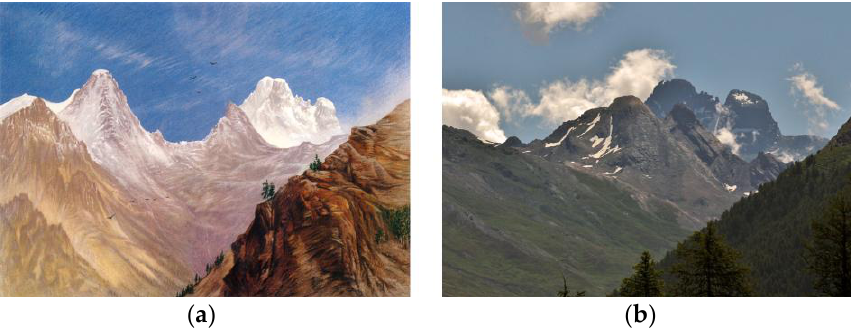
Figure 3. Example of pictorial distortion of orography and pictorial artefacts to produce a sublime image, evident in this comparison of a painting and a photograph of Monte Viso in the Cotian Alps. ( a ) Painting of the second half of 19th century by Elijah Walton (1832–1880) [29] (p. 130); ( b ) Photograph of Monte Viso from approximately the same point of view as the painting. From the comparison some pictorial artefact are evident: the distortion of the alpine orography with a stretch of the vertical dimension, the exaggeration of the rocky features, an exaggerate use of aerial perspective and very bright colors for the upper part of the mountain in order to suggest an even higher elevation of the peak.